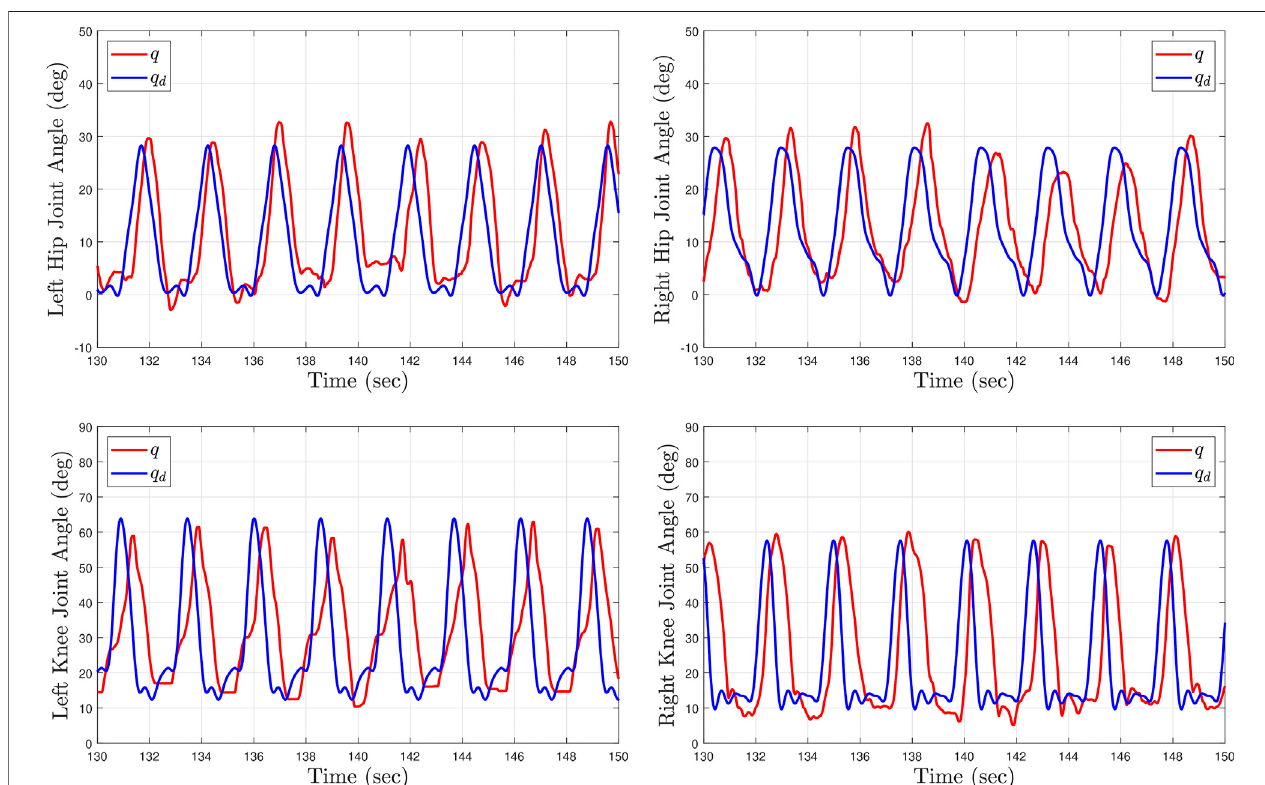
FIGURE6| KinematictrackingperformanceforSubject2(S2)after2 minutesoftreadmillwalkingathighspeed(0.8 mph).Thetopplotsdepicttheleftandrighthip jointkinematics. The bottom plots depict the left and right knee jointkinematics. The blue curves illustrate the desired kinematic trajectories and thered curves show the actual joint